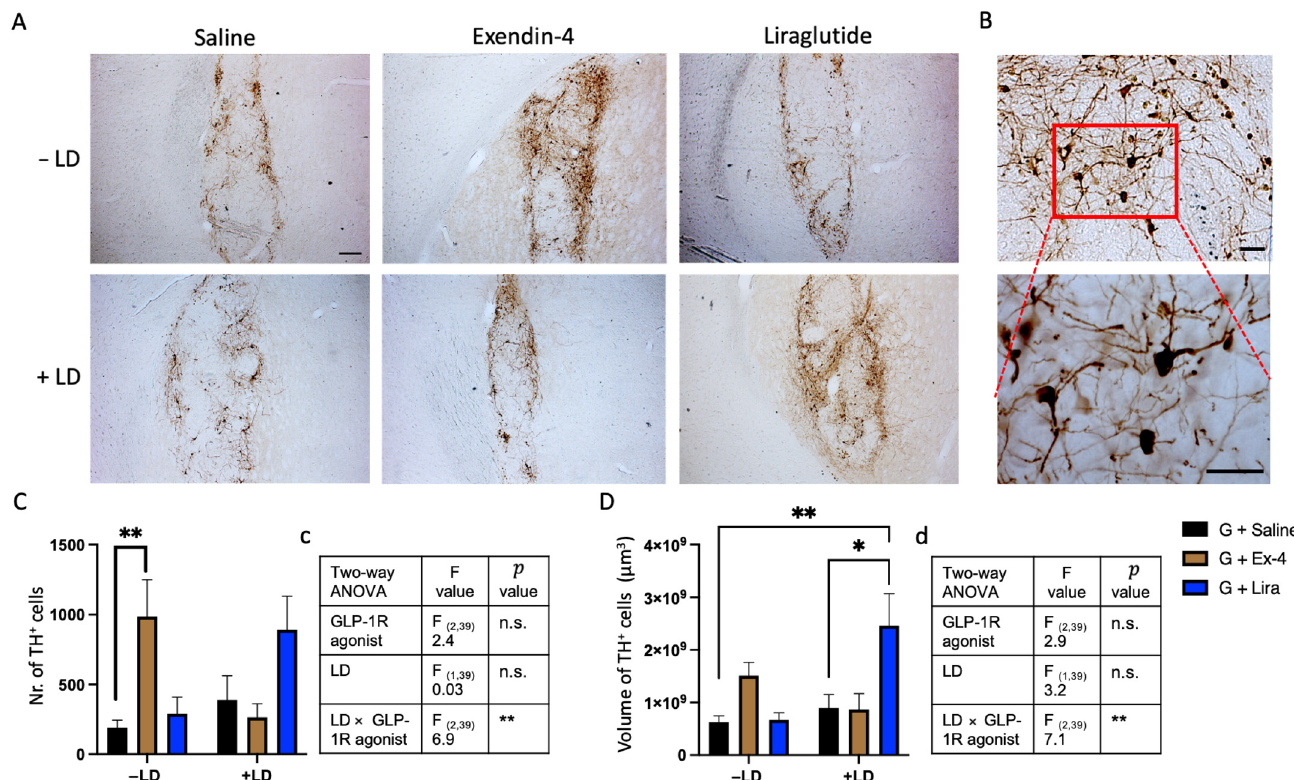
Figure 4. The effect of GLP-1R agonists and L-dopa on the number and volume of the graft TH+ cells: ( A ) bright field images captured at 4 × magnification showing TH+ graft in the striatum of the rats received either saline, exendin-4 or liraglutide and treated +/ − LD. ( B ) bright field image of the TH+ cell captured at 10 × magnification (upper) and 40 × magnification (lower) from the graft in the striatum of a rat in Ex-4/ − LD group showing the TH + cell morphology. ( C , D ) the TH + cell counting and the volume of TH + cells respectively in the graft of the rats received either saline, exendin-4 or liraglutide and treated +/ − LD. ( c , d ) illustration of statistical sumary of ( C , D ) analysis respectively. Two way ANOVA * p < 0.05, ** p < 0.01. n = G − LD (7), G + LD (8), G − LD + Ex-4 (9), G + LD + Ex-4 (8), G − LD + Lira (6), G + LD + Lira (7). n.s. = not significant LD = L-dopa; Ex-4 = Exendin-4; Lira = Liraglutide TH = tyrosine hydroxylase. Scale bar = ( A ) 200 μ m, ( B ) 50 μ m.